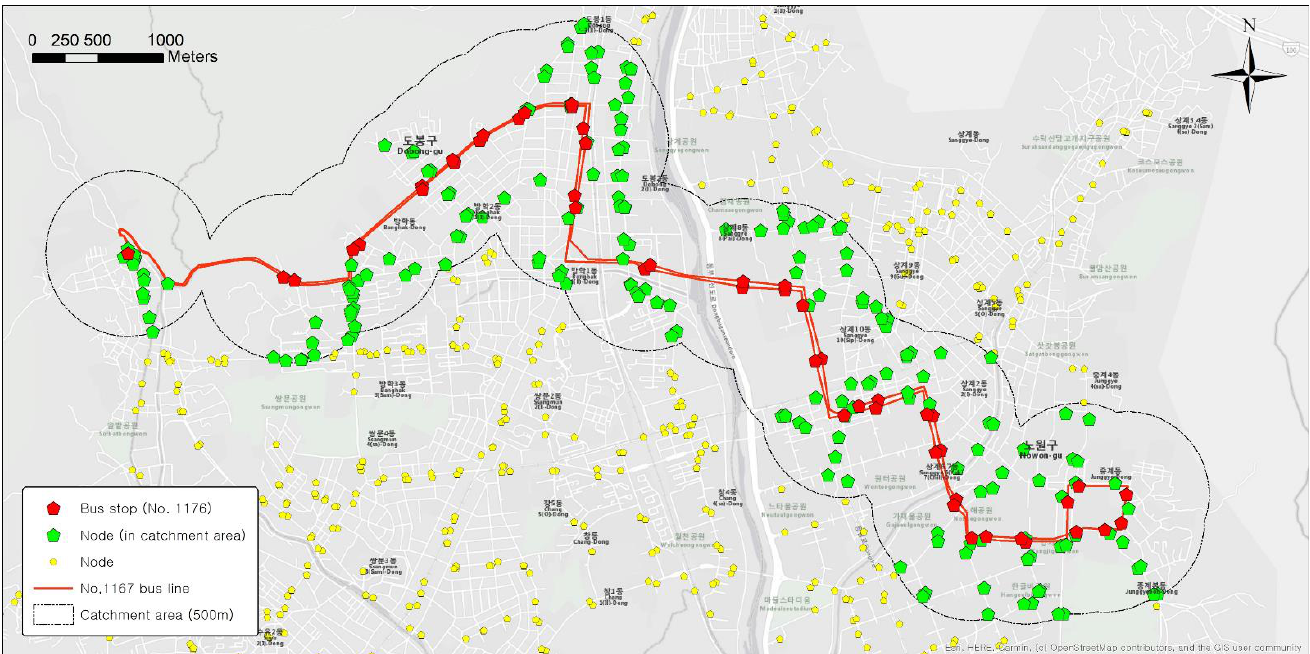
Figure 5. Map of route of bus No. 1167.